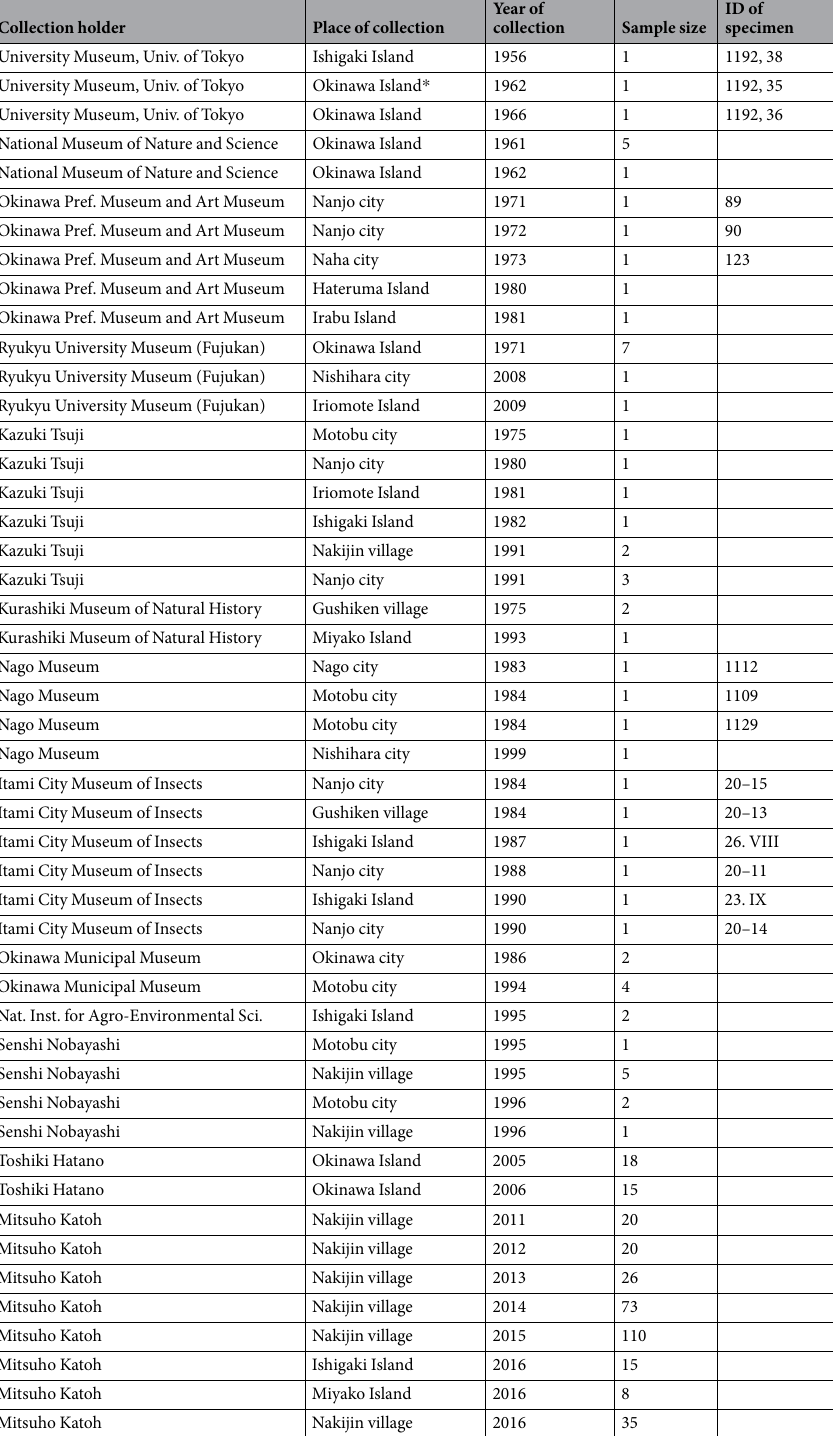
Table 2. Specimen information. * Denoted simply as ‘Okinawa Island’ when the locality on the island was not identified on the